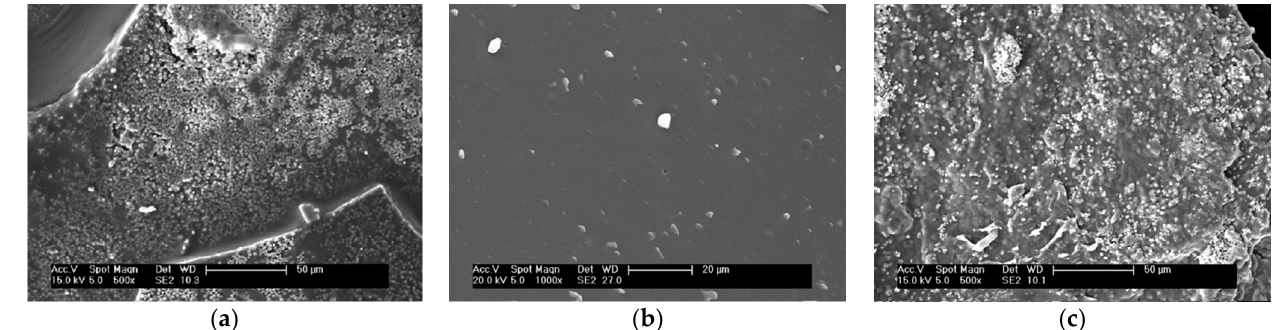
Figure 2. Scanning electron microscopy (SEM) images of white sediment ( a ), yellow sediment ( b ) and irreversible sediment ( c ).